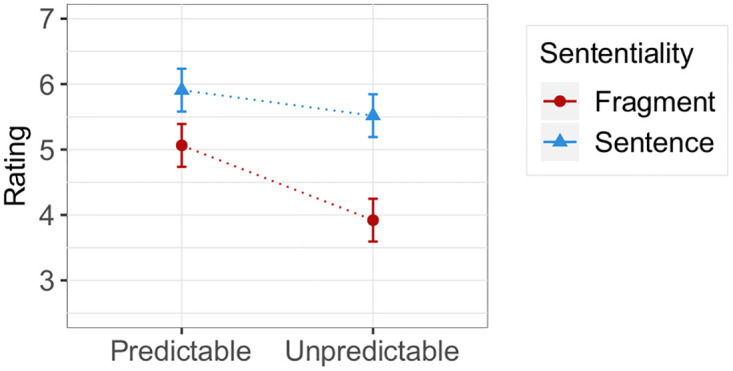
Mean ratings + 95% CIs across conditions.